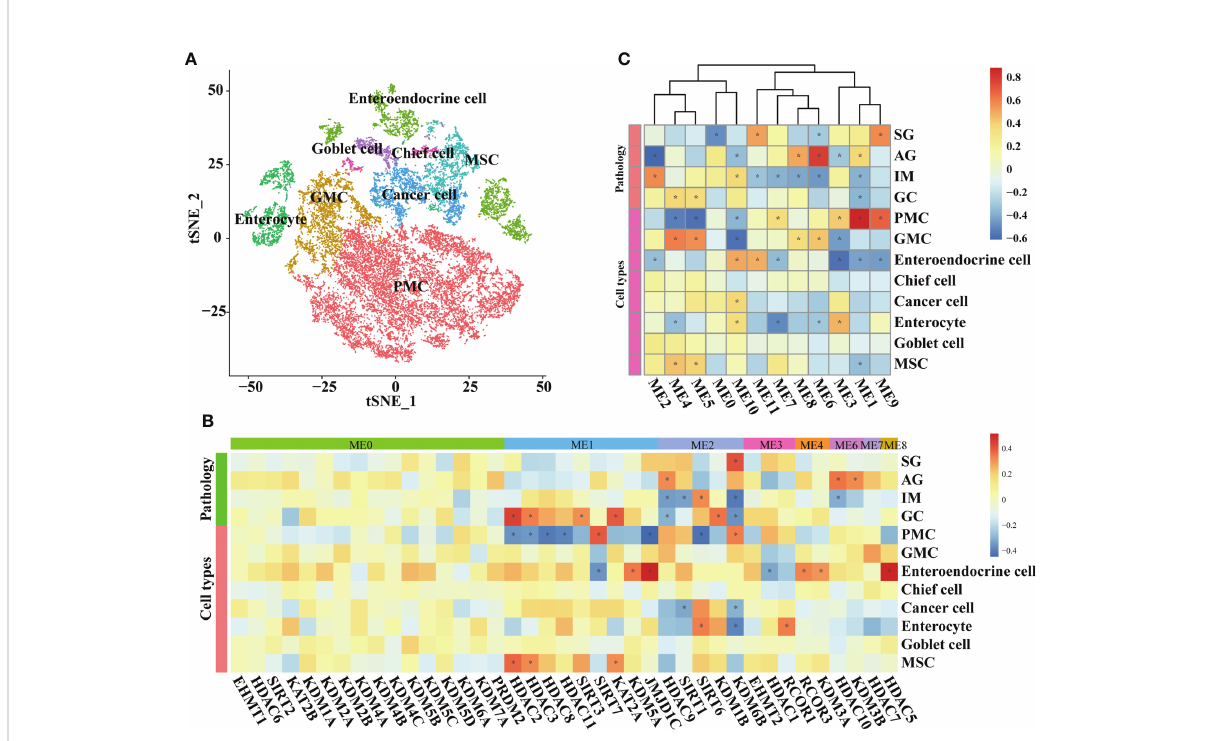
FIGURE 4 WGCNA on epithelial lineage cells based on scRNA-seq transcriptomes. (A) t-SNE plot visualizing epithelial lineage cells. Heatmaps illustrating modules – trait relationships (B, C) HMGs – trait relationships. The trait data were composed by lesions and cell types. The module af fi liations of HMGs were labeled by the color bars on the top of the column. The symbol * means FDR adjusted p value for the labeled correlation was less than